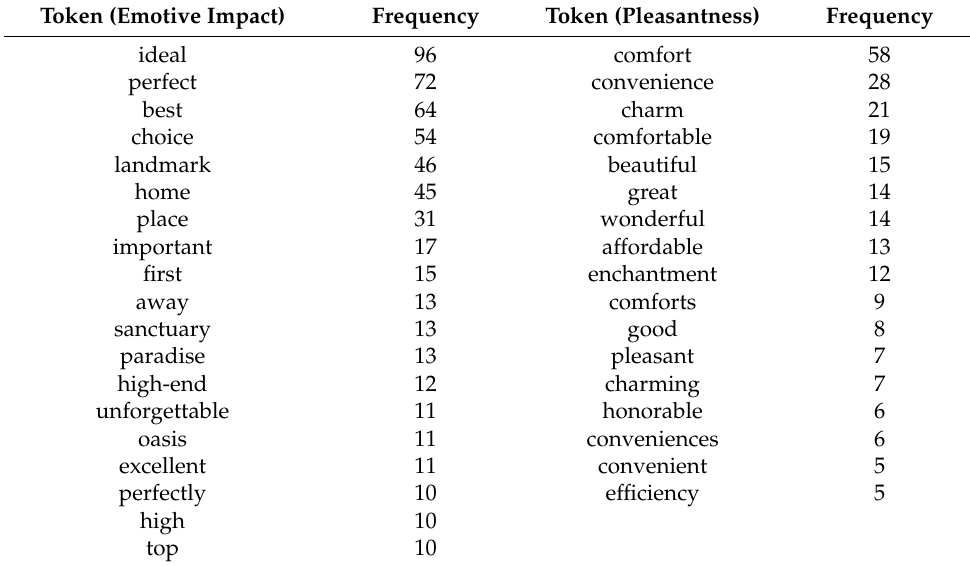
Table 3. Expressions in the emotive impact and pleasantness.